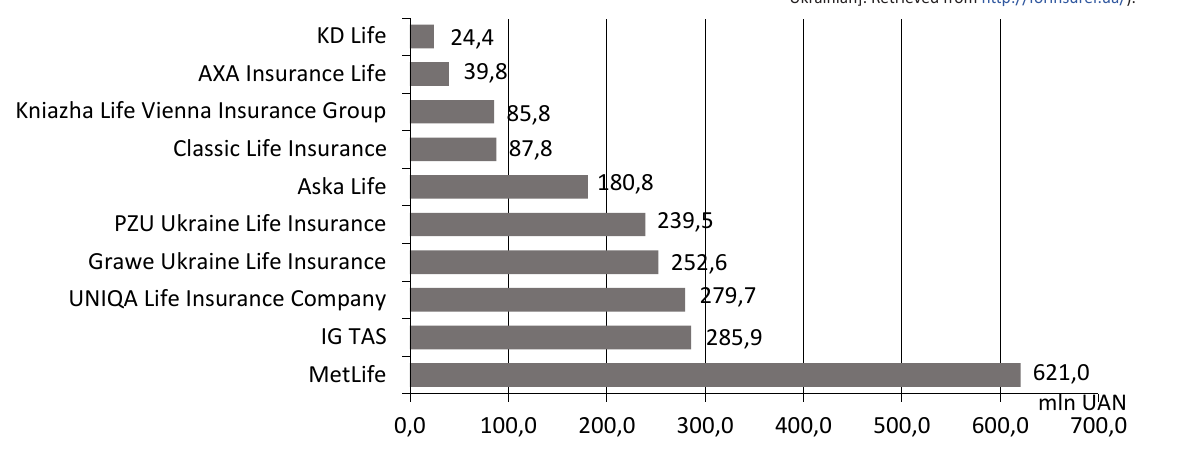
Figure 4. Life insurance leaders in Ukraine in